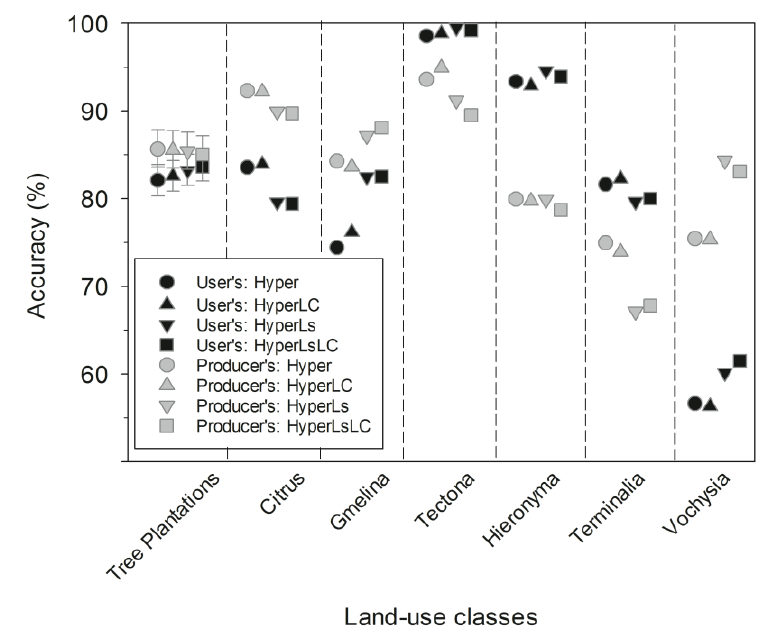
Figure 7. Producer’s and user’s accuracy across the four Random Forest models for tree plantations as a general class (left column; mean ±95% CI) and for each tree plantation species. Producer’s and user’s accuracy are defined in Figure 6. Please note that, for clarity, the order of the species and RF models has changed slightly from other figures. The three non-native species are grouped on the left, while the three native species are grouped on the